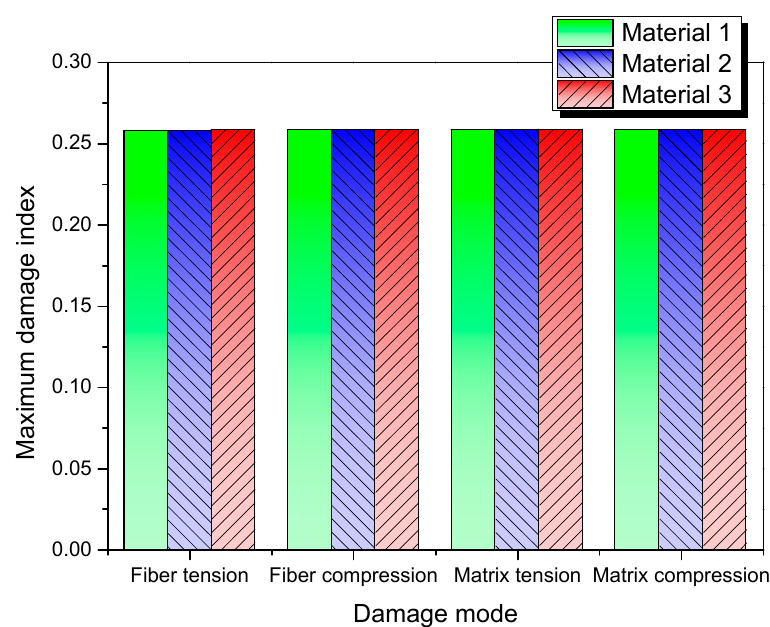
Figure 19. Maximum local damage indices for different damage modes in the three models.